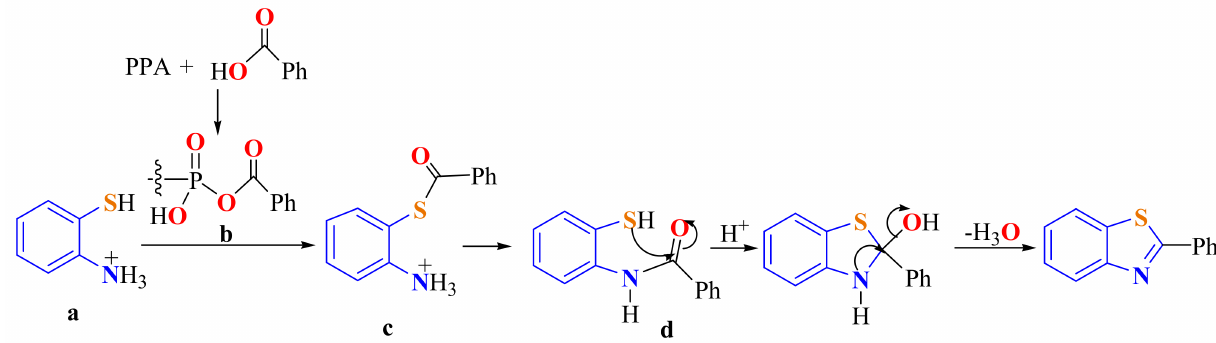
Scheme 4. Proposed mechanistic path way in the condensation of o -aminothiophenol with carboxylic acid in PPA.